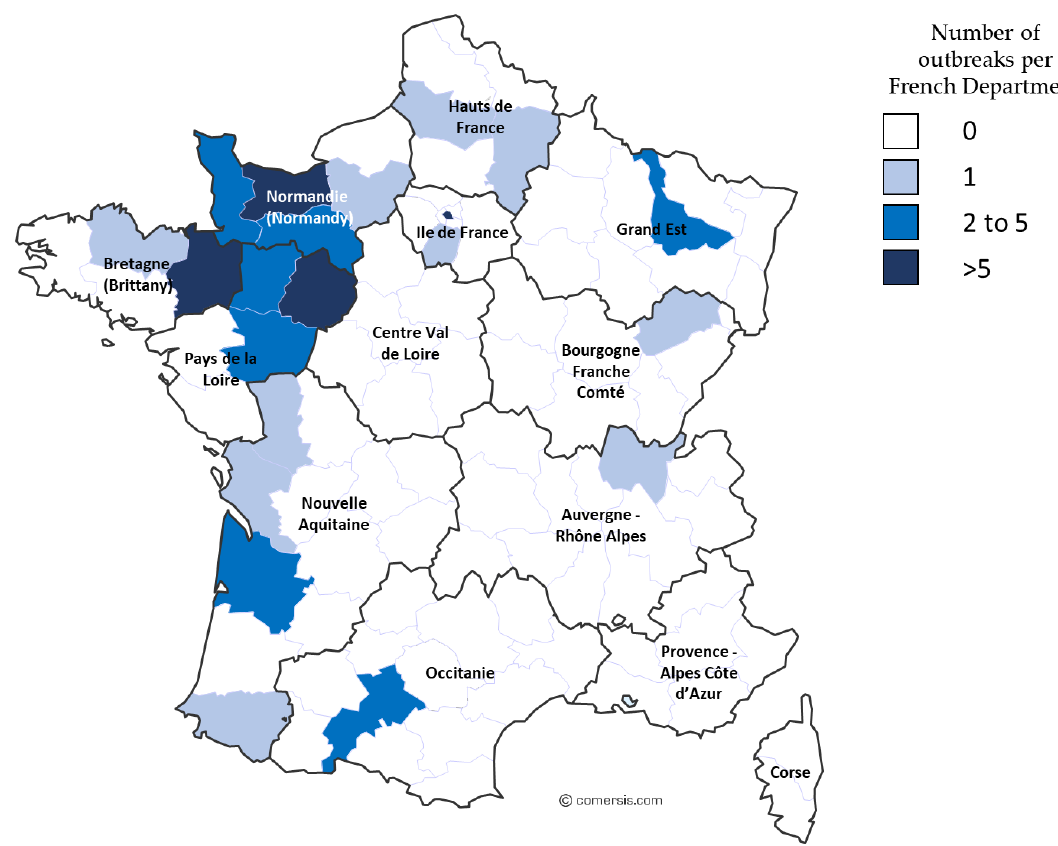
Figure 2. Map of France illustrating EHV-1 outbreaks reported to the RESPE in 2018, with frequency and geographical location.